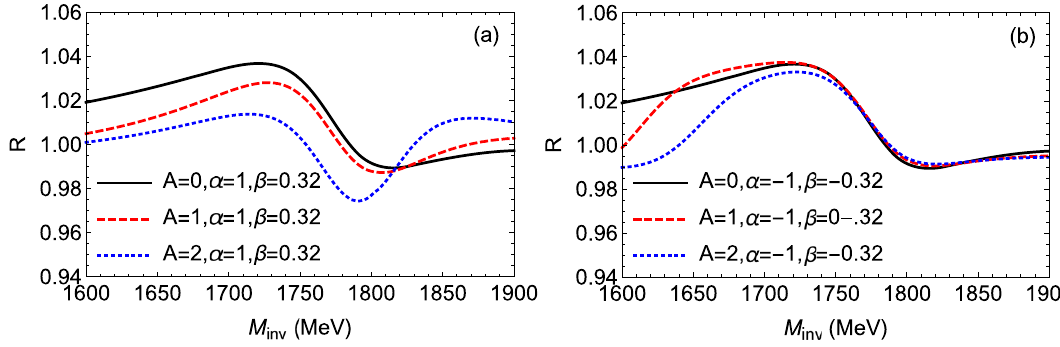
Fig. 10 Ratio between the differential decays for the reactions J /ψ → φ K + K − and J /ψ → φ K 0 ¯ K 0 , taking distinct